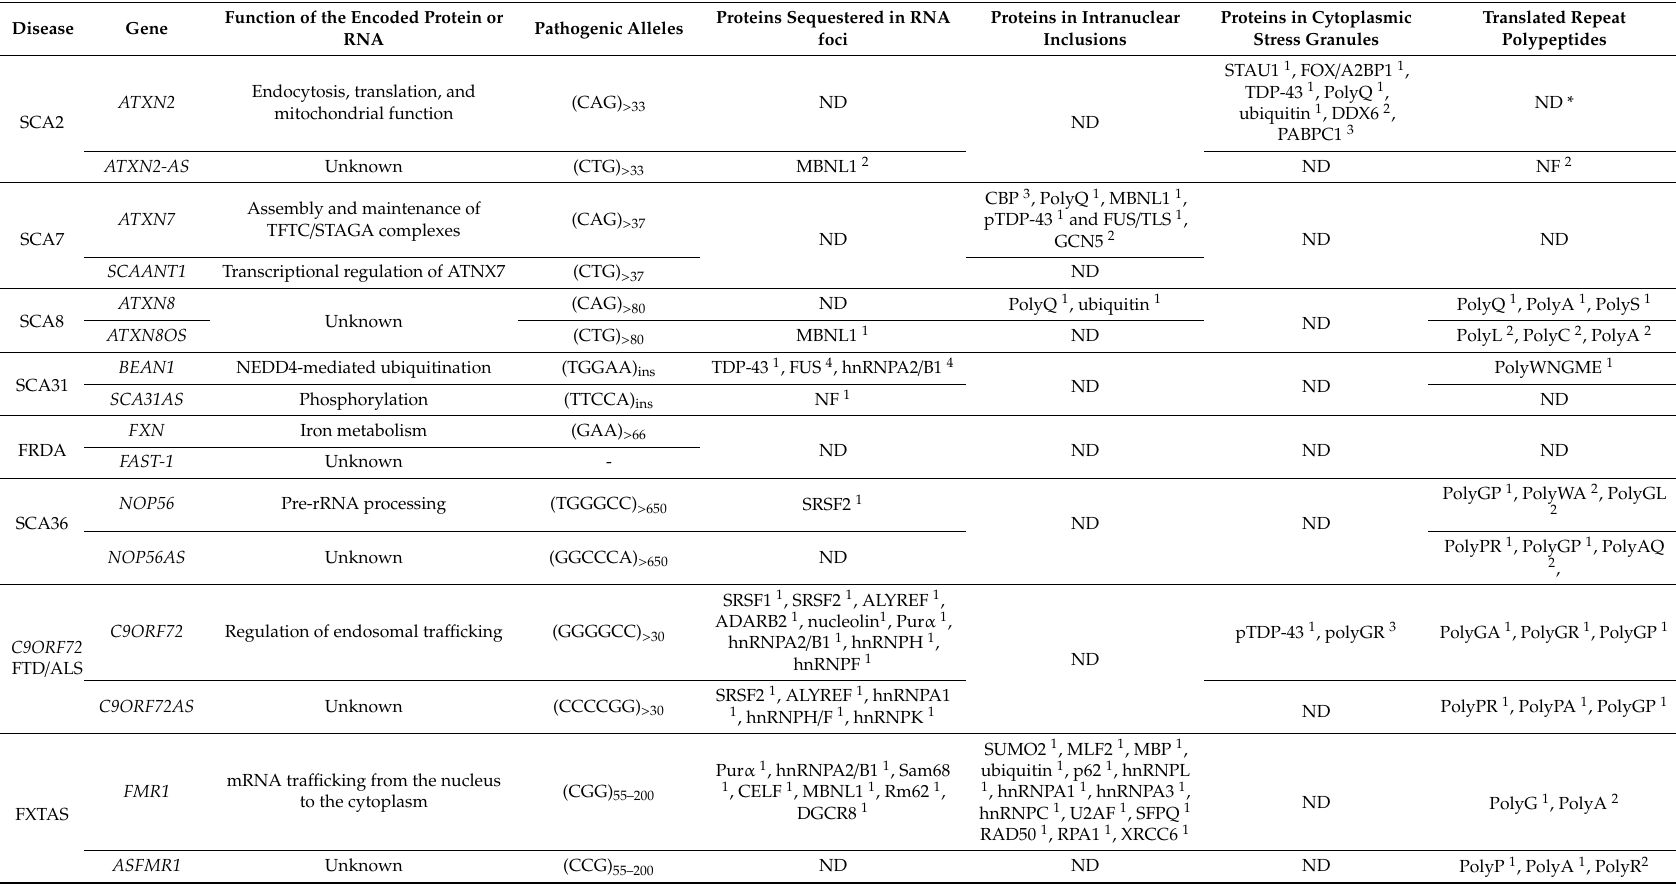
Table 1. Neurodegenerative and neuromuscular diseases with antisense repeat expansion